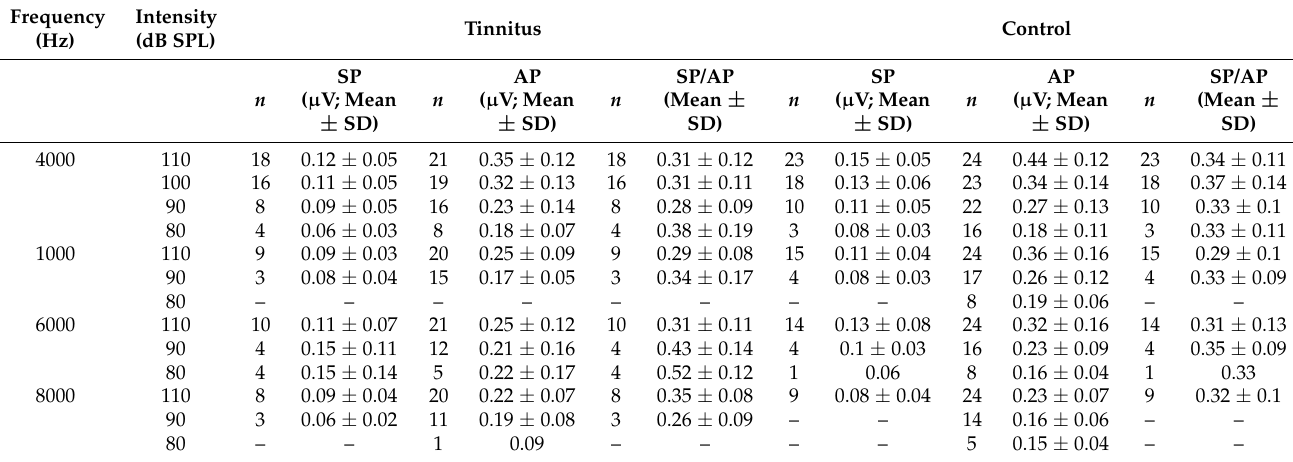
Table 4. Descriptive statistics of the ECochG test results in the two